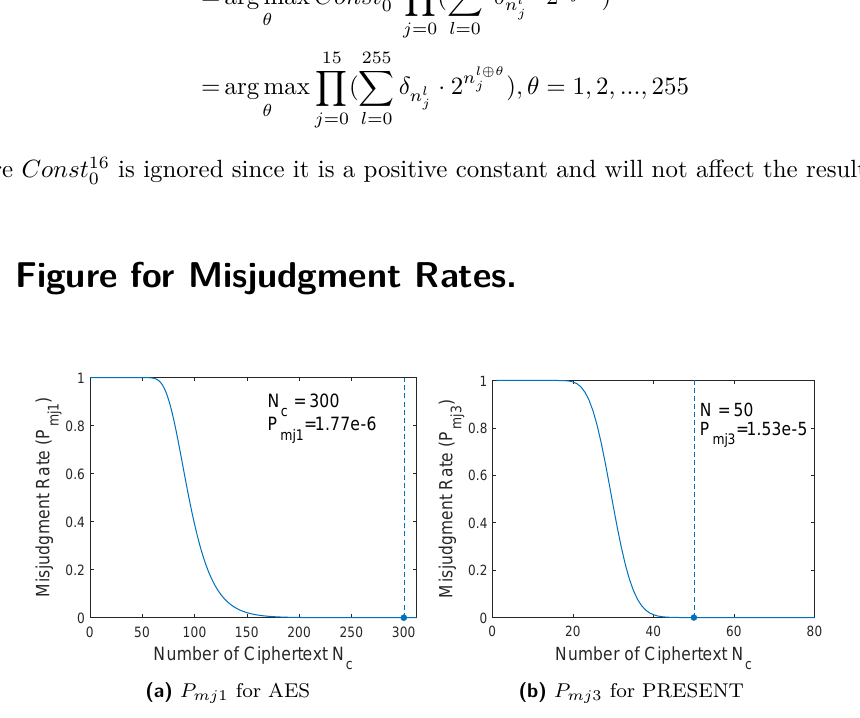
Figure 13: The relation between the misjudgment rates and N c . Both of them will be negligible with proper number of